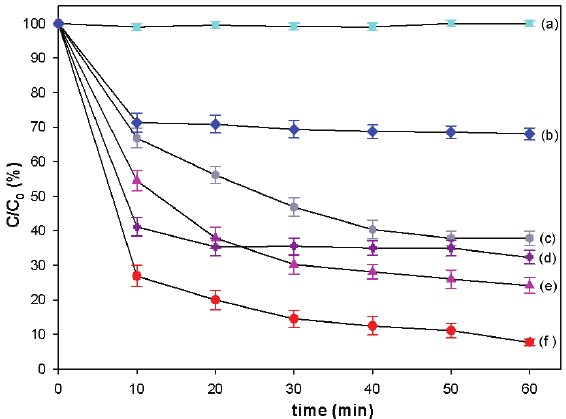
Figure 8: Effect of time on adsorption and photocatalytic degradation of RB under different conditions: (a) UV irradiation; (b) adsorption on sponge skeleton in visible light; (c) H (d) adsorption on CuPC- Hc S in visible light; (e) CuPC- Hc S in UV; (f) CuPC- Hc S and H O in 2 2